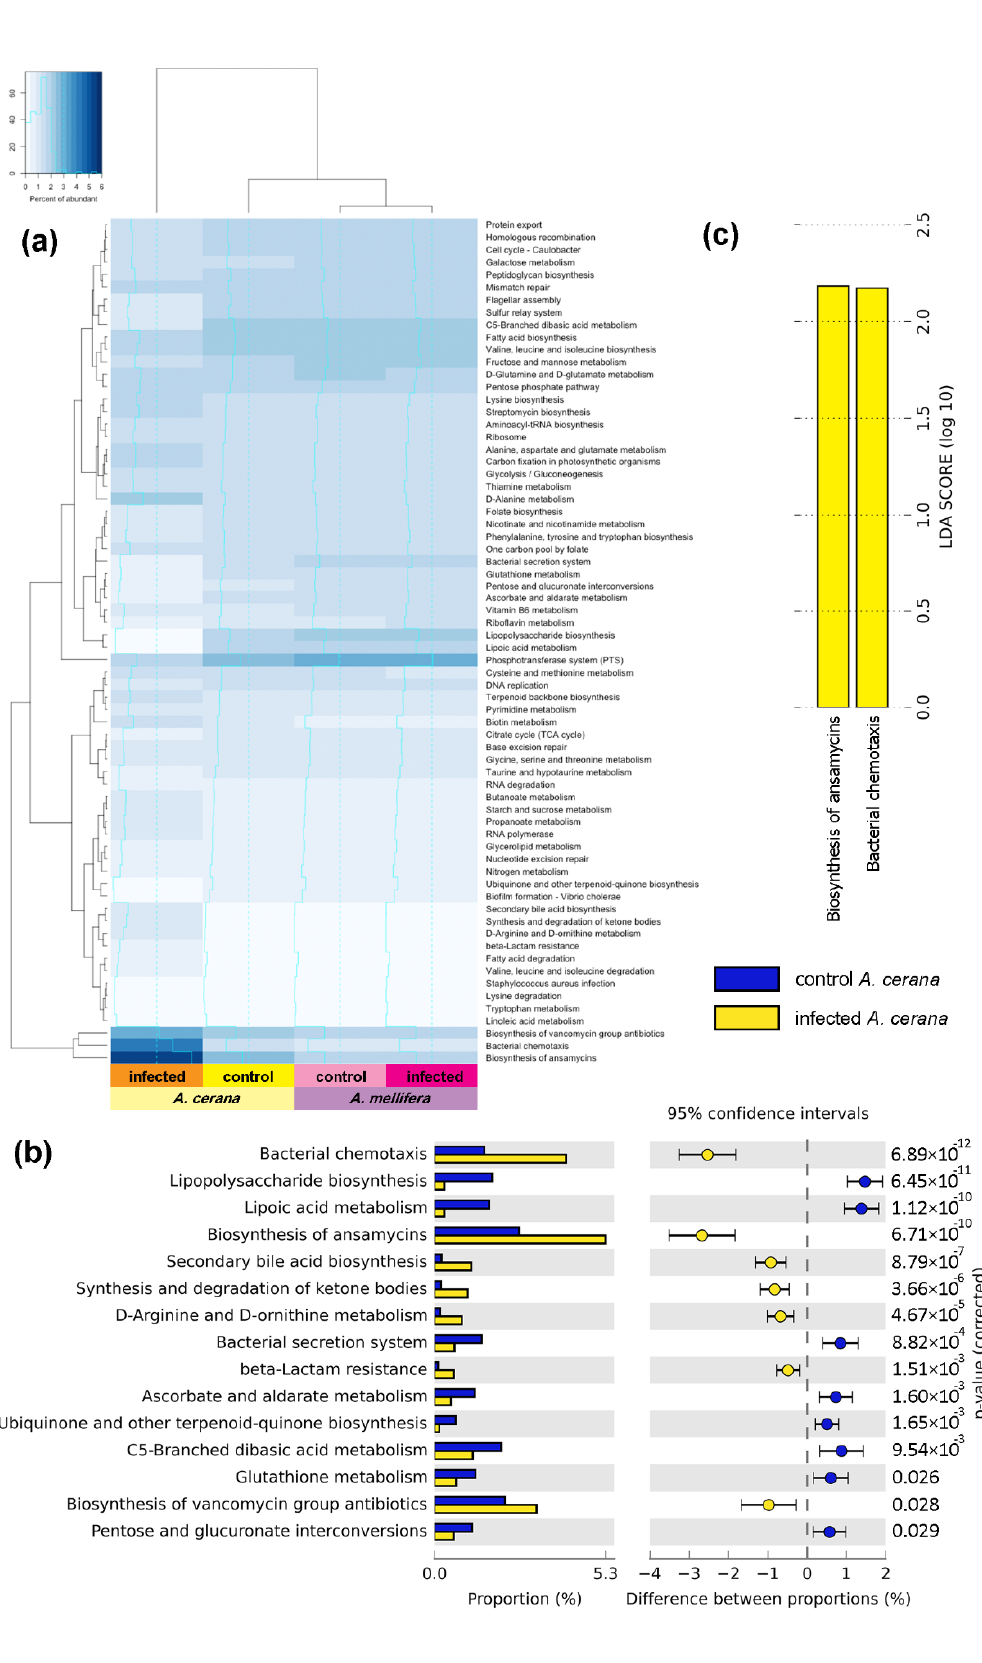
Figure 5. A heat map of gene expression in control and SBV-infected bee larvae. There was a high abundance of biosynthesis of ansamycins and bacterial chemotaxis function ( a ) with p-value of difference between proportions ( b ) and LDA score of biosynthesis of ansamycins and bacterial chemotaxis in bee larvae after viral infection ( c ).